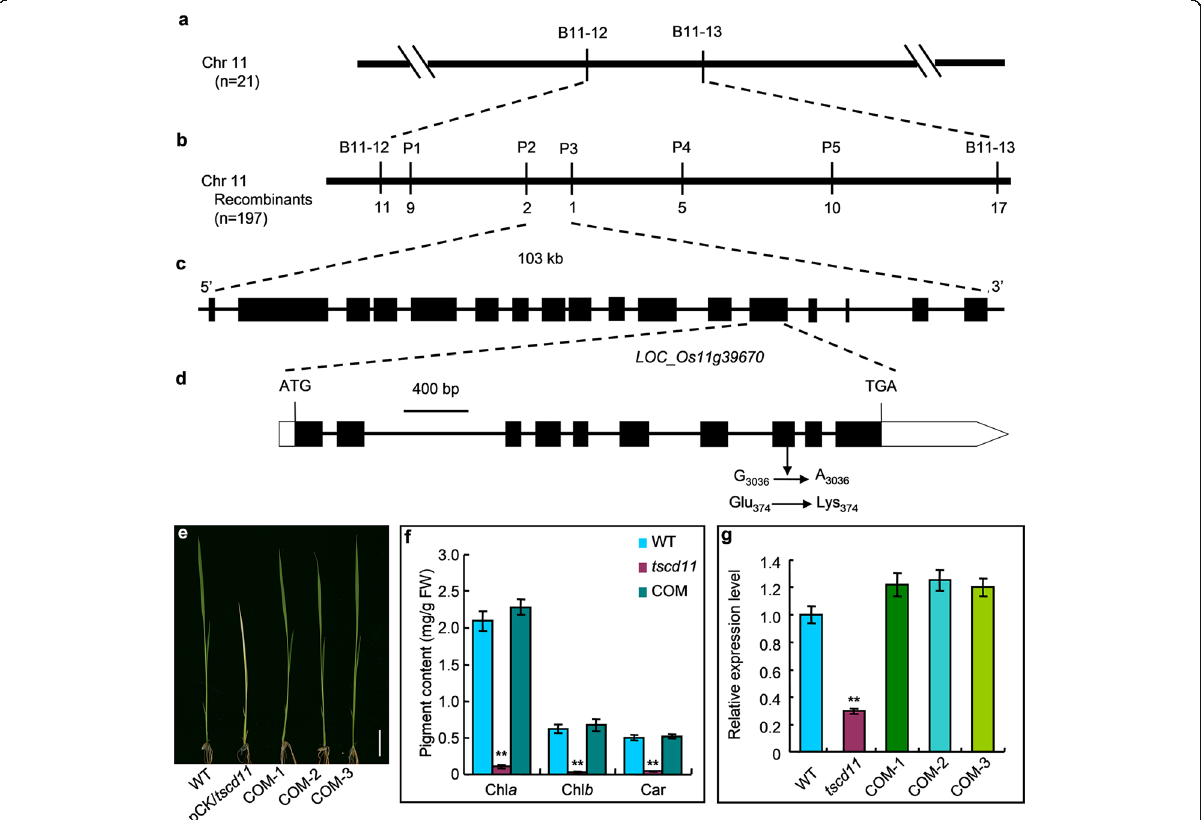
Fig. 3 Map-based cloning of TSCD11 and transgenic complementation of the tscd11 mutant. a , b The TSCD11 locus was initially mapped on chromosome 11. c , Fine mapping the TSCD11 locus. d , TSCD11 gene structure and mutation site of TSCD11 . e , phenotypes of wild-type, tscd11 with pCMBIA1300 (pCK/ tscd11 ) and three independent tscd11 complementation plants (COM-1, 2 and 3) at 35 °C (bar = 2 cm). f , pigment contents of wild-type, tscd11 and complementation plants g , Relative transcript levels of TSCD11 in wild-type, tscd11 and complementation plants at the 3- leaf stage at 35 °C. The rice Histone gene was used as an internal control. The transcript level of TSCD11 in the WT at 35 °C was set to 1.0. Data represent the mean ± SD (n = 3). ** p < 0.01 (Student ’ s t